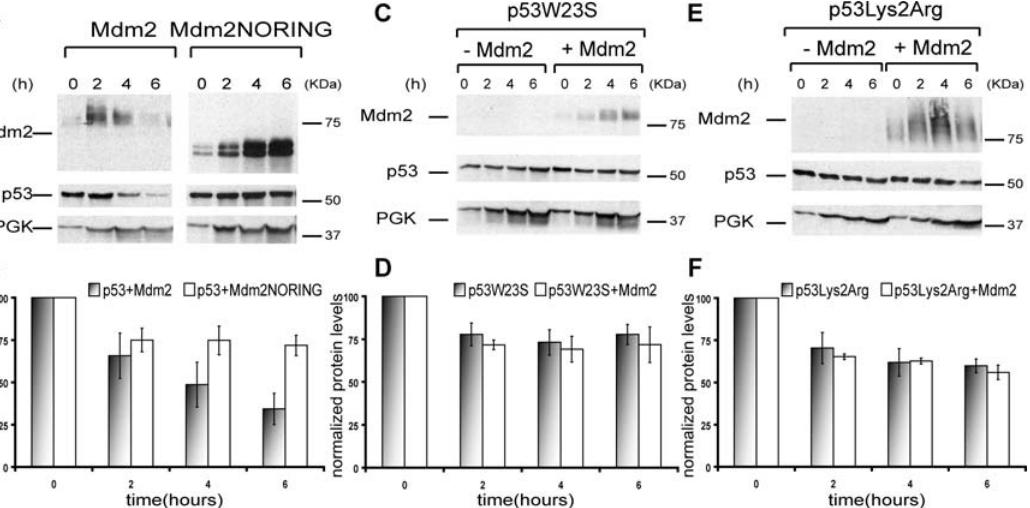
Figure 2. Mdm2 ubiquitylates p53 in yeast leading to p53 degradation. ( A) Total yeast cell extracts from exponentially growing cells were immunoblotted for the indicated proteins over time. 3-phosphoglycerate kinase (PGK) was used as loading control. (B) Quantifications of protein levels are shown. Data represent the mean 6 standard error (SE), for n=3 independent experiments. (C,D) as in (A,B) but for p53W23S. (E,F) as in (A,B) but for